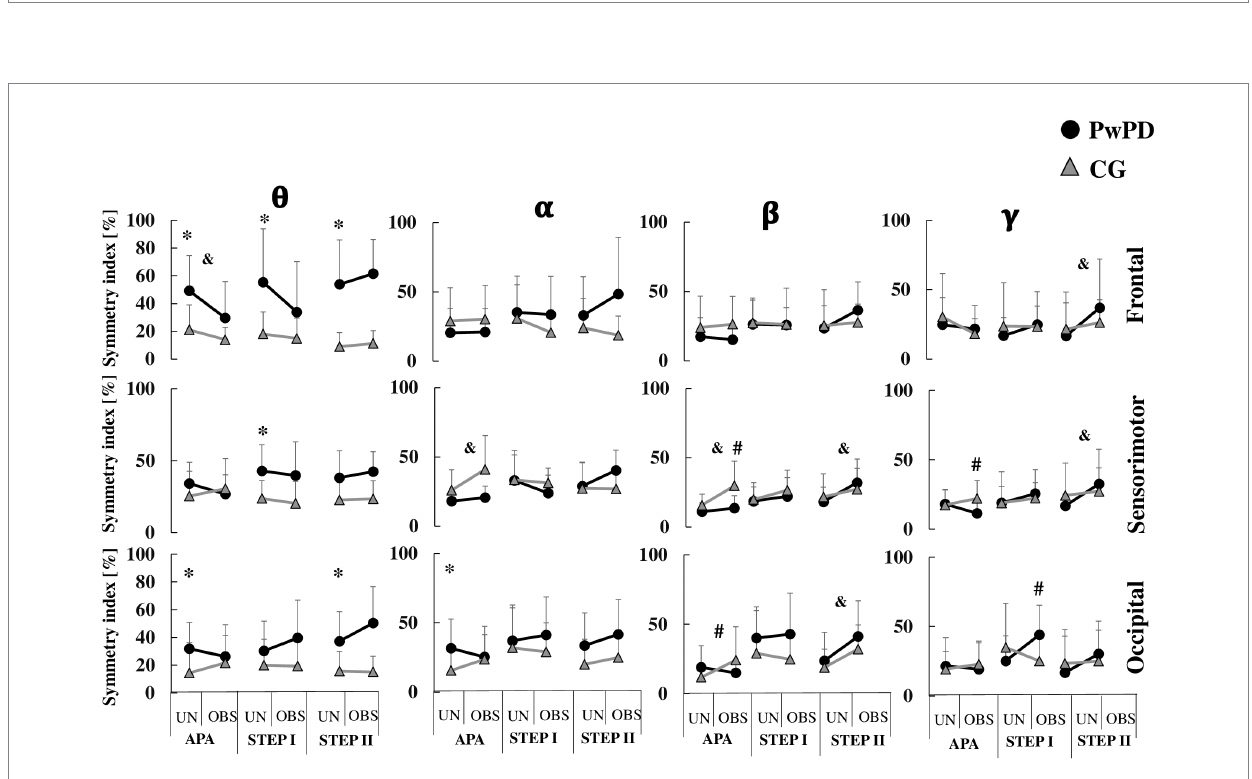
FIGURE 3 Means and standard deviations of the PSD symmetry index of theta ( θ ), alpha ( α ), beta ( β ), and gamma ( γ ) bands in each brain region (frontal, sensorimotor, and occipital areas) in the PwPD and CG. The cortical activity is presented according to APA, STEP I and II phases during unobstructed (UN) and obstructed (OBS) gait initiation. *: Significant main effect of group; &: Significant main effect of GI condition; #: Significant group by condition interaction. For clarity, the symbol for a significant main effect of group (*) is located on the left of each sub-figure, where the unobstructed data is